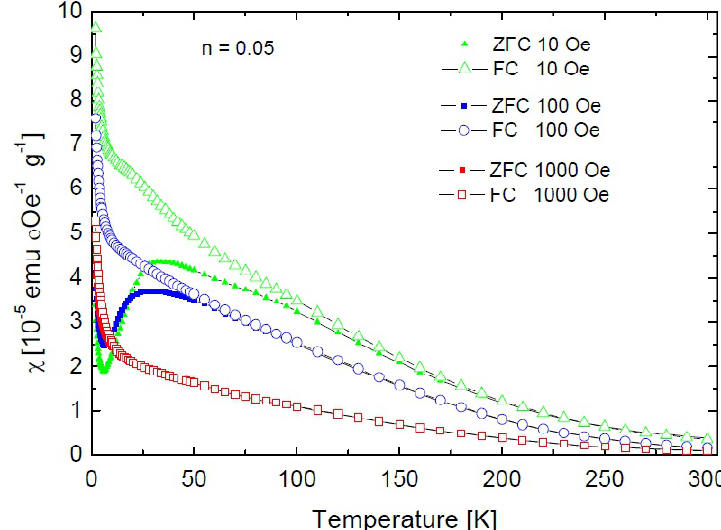
Fig. 5. Temperature dependence of the dc magnetic susceptibility  ( T ) for n = 0.05 sample in ZFC and FC modes in external magnetic fields H = 10, 100, and 1000